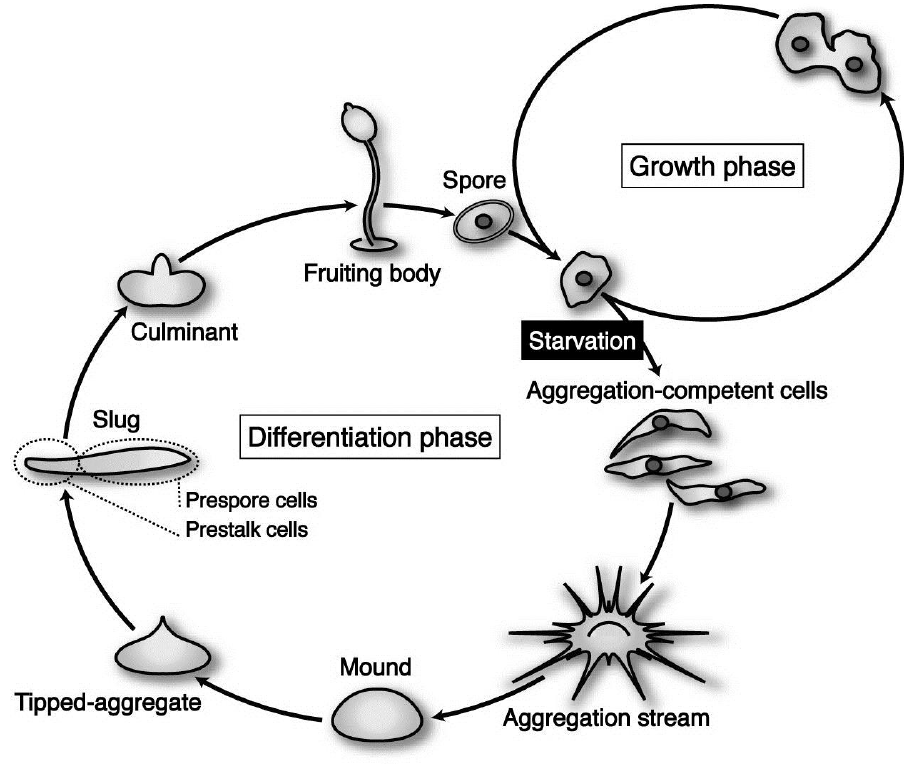
Figure 1. The life cycle of Dictyostelium discoideum axenic strain Ax-2. The vegetative cells are usually grown in liquid medium, by means of pinocytotic incorporation of external nutrients. Under natural conditions, its parental strain D. discoideum NC-4 grows and multiplies by mitosis at the vegetative phase, phagocytosing nearby bacteria such as Escherichia coli and Klebsiella aerogenes . Upon exhaustion of nutrients, however, starving cells initiate differentiation, form multicellular structures (aggregates; mounds), and undergo a series of well-organized morphogenesis to construct fruiting bodies, each of which is consisting of a mass of spores (sorus) and a supporting cellular stalk. (see the text for